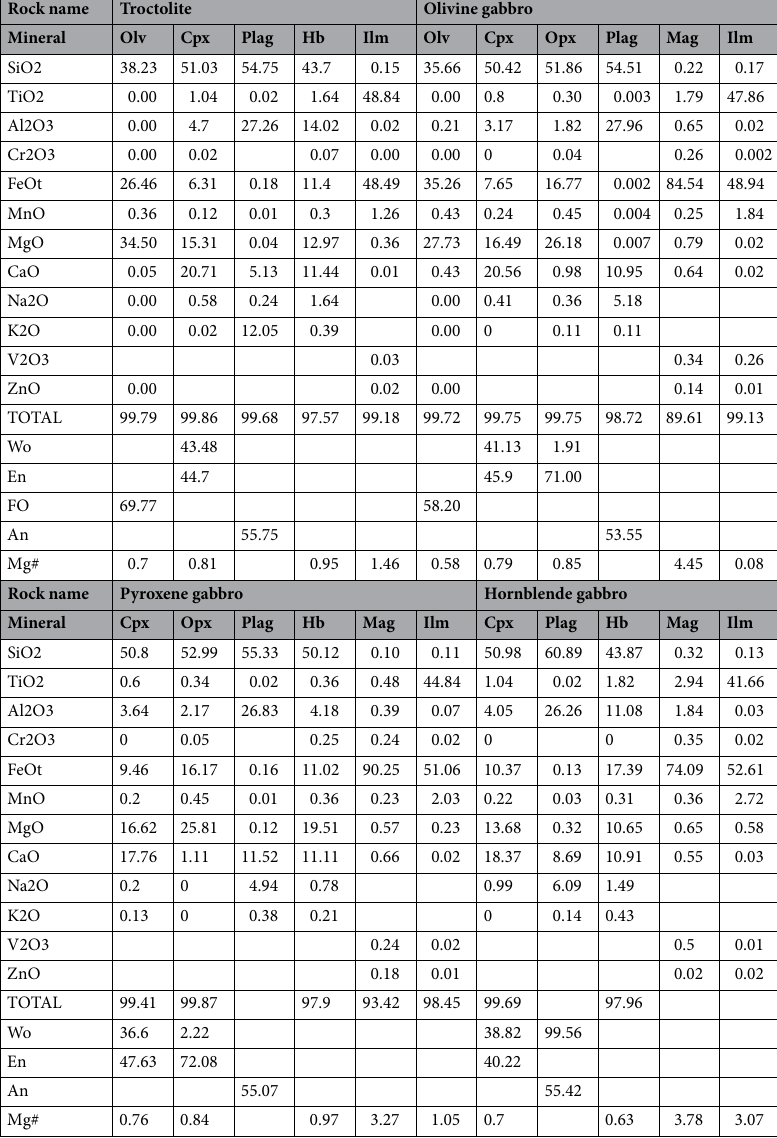
Table 1. Average microprobe analyses of clinopyroxene, plagioclase, orthopyroxene, hornblende, olivine and Fe–Ti oxides from Akab El-Negum mafic rocks. Olv Olivine, Cpx Clinopyroxene, Plg Plagioclase,